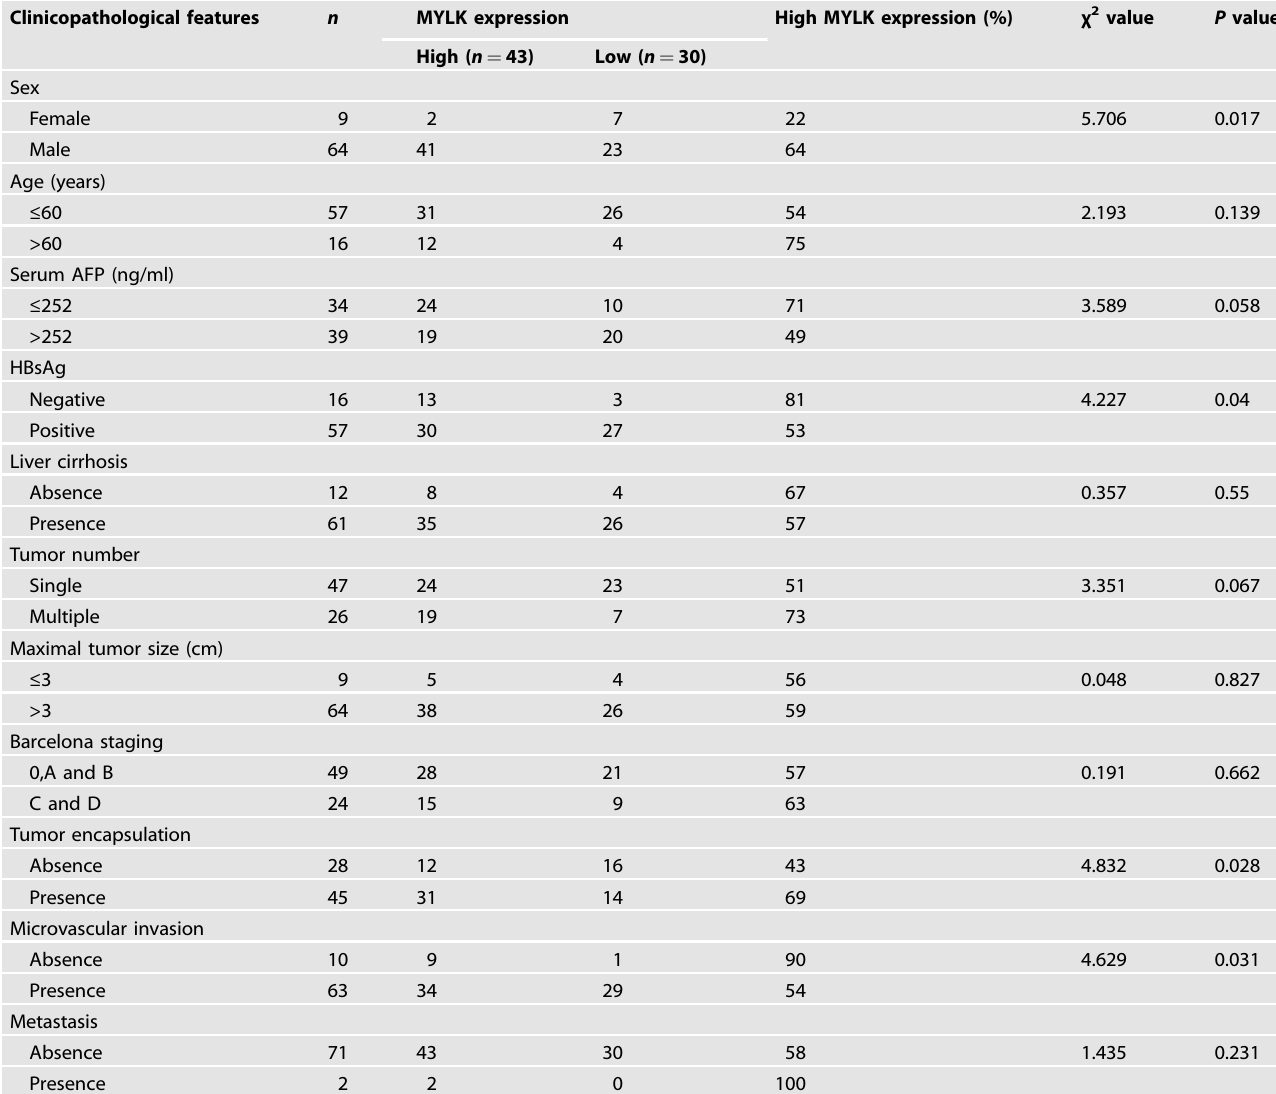
Table 1. Association of MYLK expression with clinicopathological characteristics in 73 HCC samples. Clinicopathological